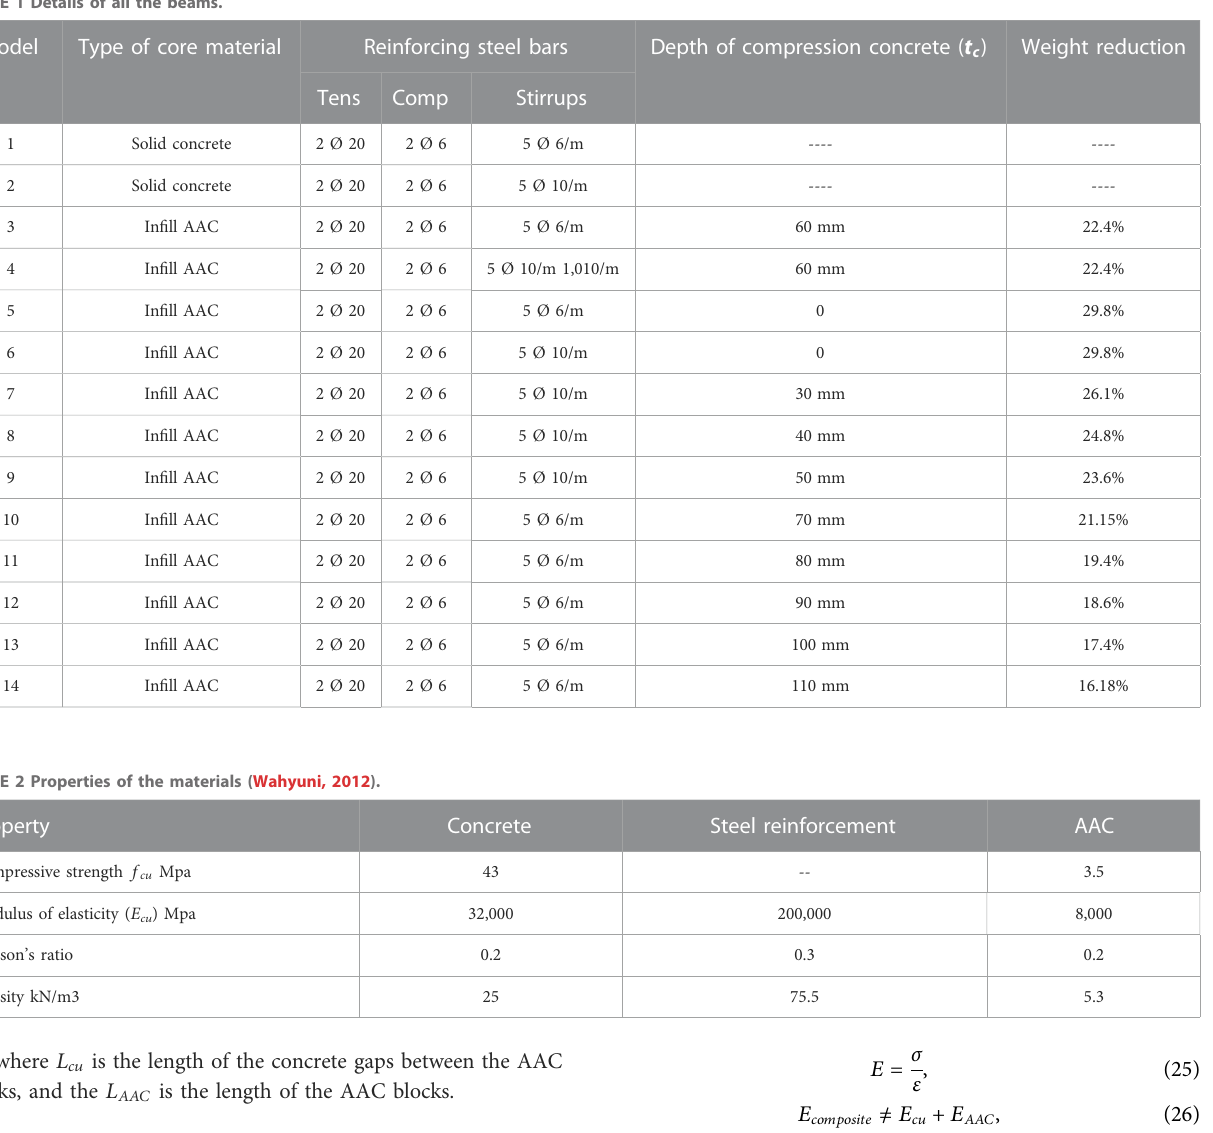
TABLE 1 Details of all the beams.